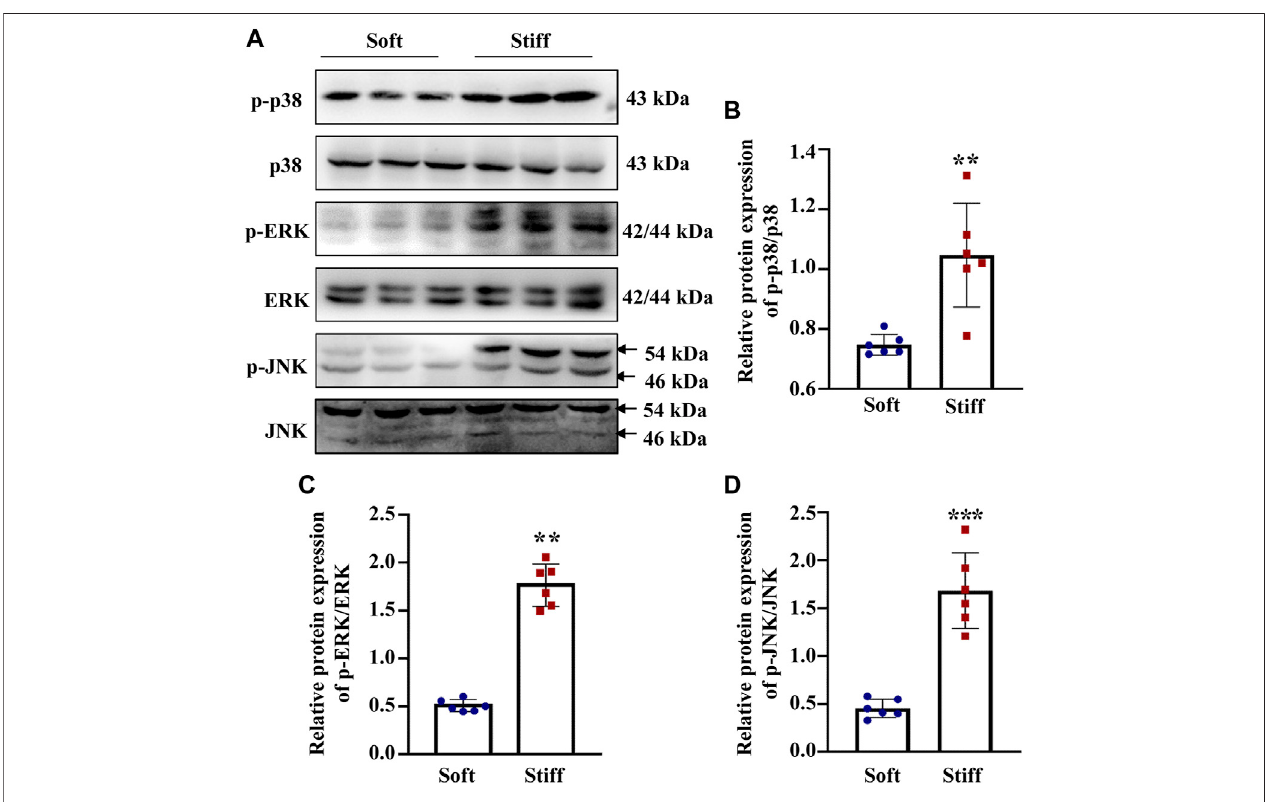
FIGURE3| ECMstiffnesspromotesMAPK signaling pathway activation. (A) Representative westernblotbandsshowtheprotein expression levels ofp-p38, p38, p -ERK, ERK, p -JNK and JNK. (B) The bar graph shows the result of semi-quantitative measurement of p-p38/p38. (C) The bar graph shows the result of semi- quantitativemeasurementof p -ERK/ERK. (D) Thebargraphshowstheresultofsemi-quantitativemeasurementof p -JNK/JNK( n (cid:1) 6;* p < 0.05,** p < 0.01,*** p < 0.001).